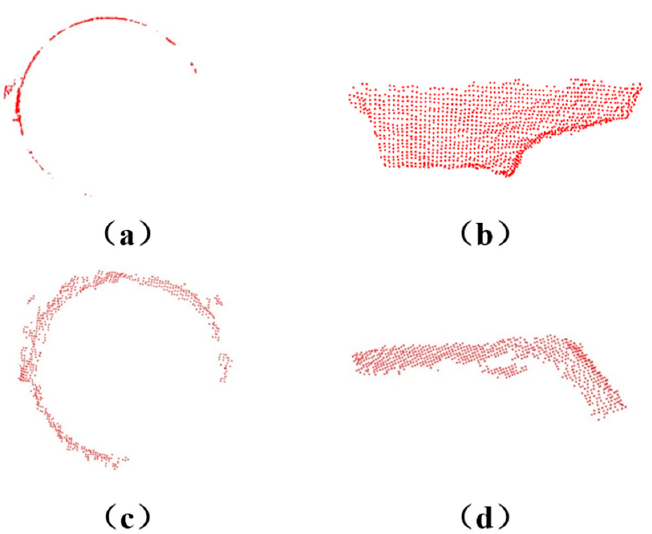
Figure 12. Grinding amount extraction point cloud map. ( a ) Ring flash point cloud. ( b ) Pouring riser point cloud. ( c ) Small circle flash point cloud. ( d ) Plane flash point cloud.